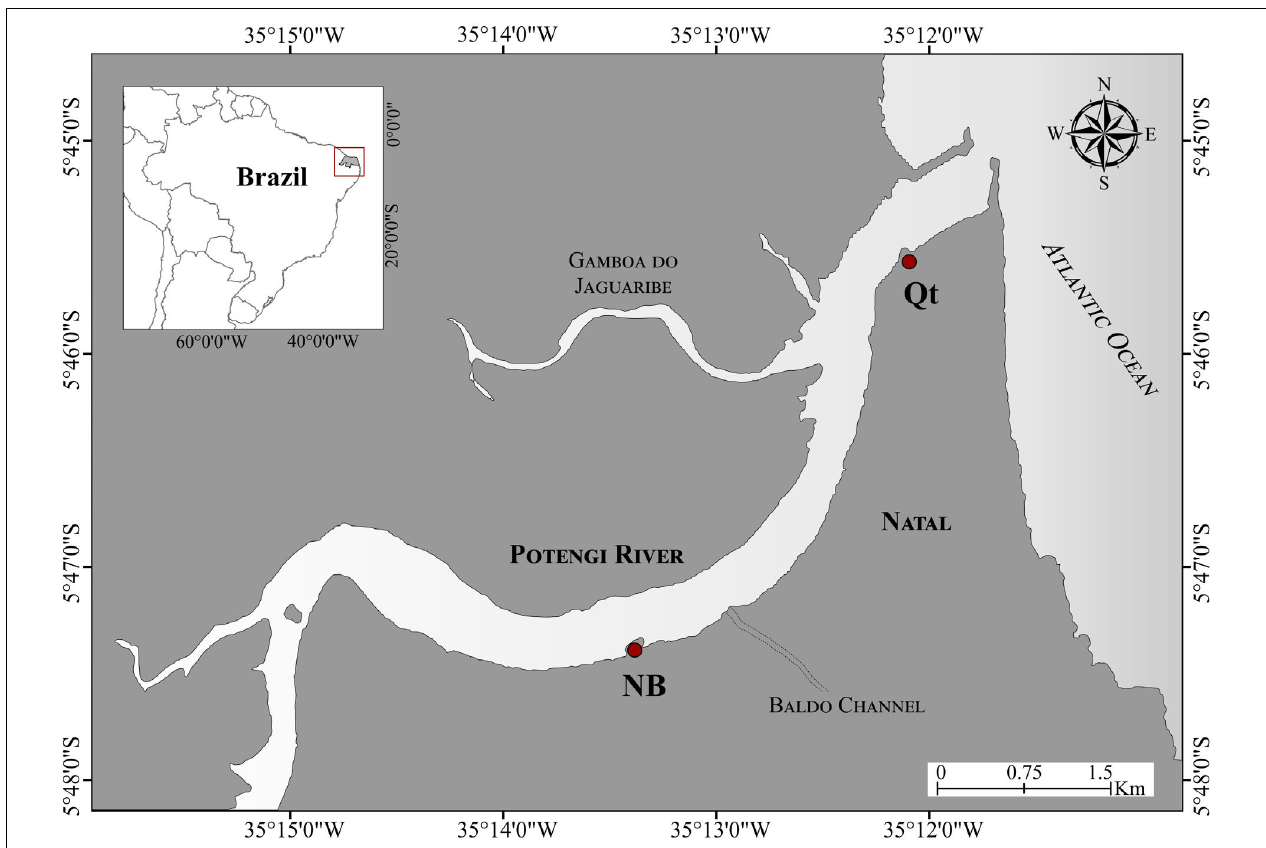
FIGURE 1 | Oyster sampling site locations at Potengi. NB, Naval Base (Brazilian Navy pier); Qt, Quartel (Y-Beach, 17th Army Artillery Group). Map created with Google Earth Pro 7.3.2 software (Image catalog ID: 1010010004319001) and CorelDraw